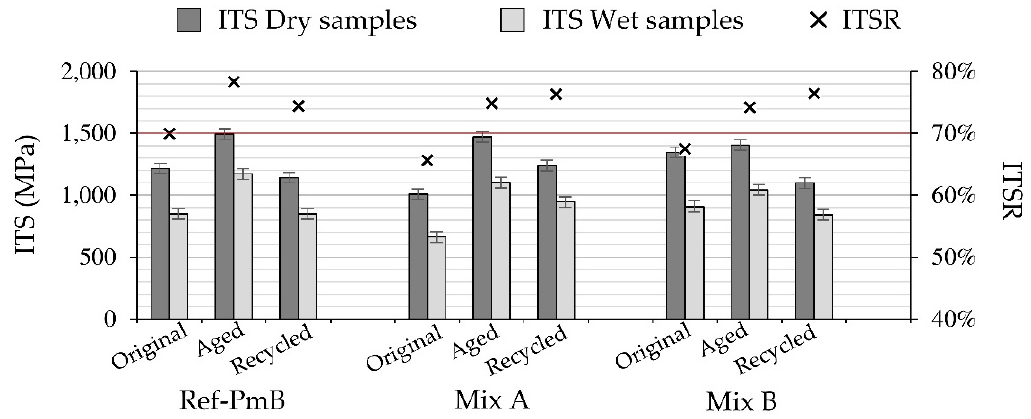
Figure 6. Indirect Tensile Strength (ITS) at 22 °C and water sensitivity test results.